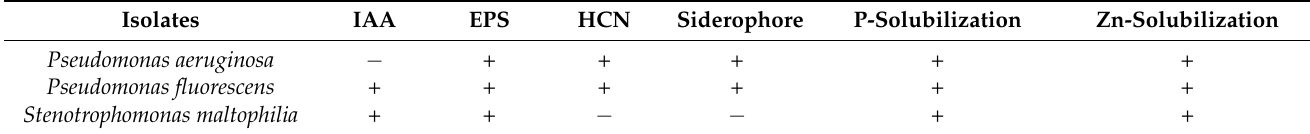
Table 4. PGP properties of studied bacteria.